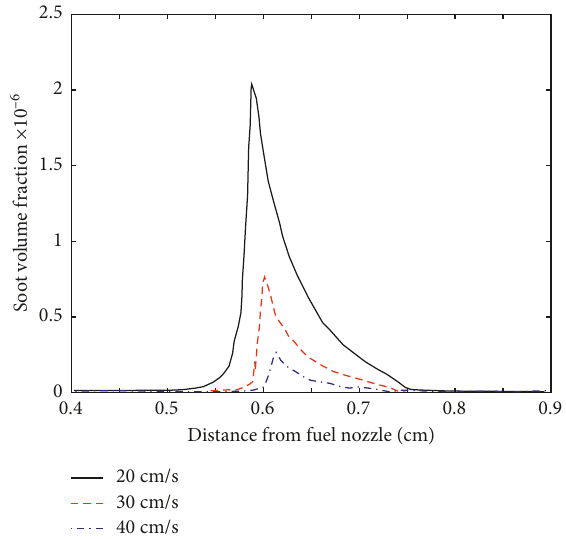
Figure 6: Profiles of soot volume fraction under various exit